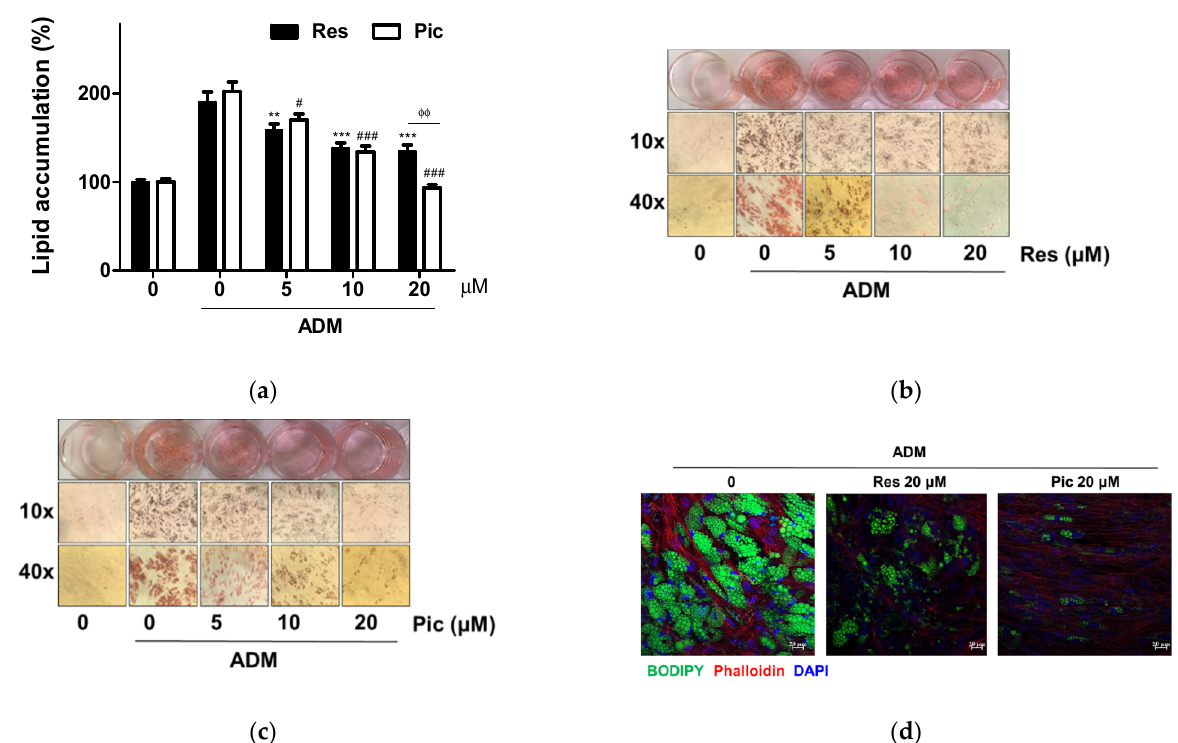
Figure 3. ( a ) Human visceral adipose-derived stem cells (vASCs) were treated with the resveratrol (Res) and piceatannol (Pic) in the absence or presence of adipogenic differentiation medium (ADM) for 14 days and stained with oil red O (ORO). Intracellular lipid accumulation levels were quantified by extracting ORO-stained lipid droplets with 100% isopropanol and the absorbance was measured at 495 nm. Data are expressed as means ± SD from three independent experiments (** p < 0.01 and *** p < 0.001 vs. ADM-only-treated group of the Res treatment groups; # p < 0.05 and ### p < 0.001 vs. ADM-only- treated group of the Pic treatment groups; ᶲᶲ p < 0.01). ( b , c ) Photographs are representative images of the three independent experiments (magnification 10× and 40×). ( d ) vASCs were treated with Res and Pic in the presence of ADM for 14 days and stained with 4,4-difluoro-4-bora-3a,4a-diaza-s-indacene (BODIPY). Confocal images of fat body stained with BODIPY 493/503, Phalloidin, and 4 ′ ,6-diamidino-2-phenylindole (DAPI) to show lipid droplets, actin filaments, and nuclei, respec- tively.